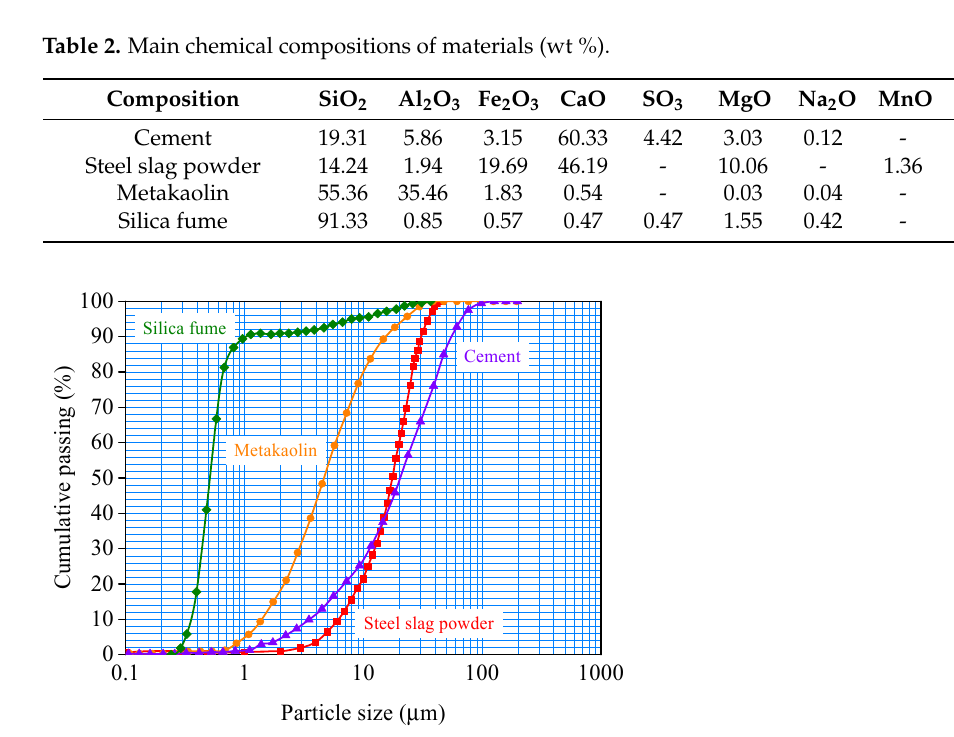
Figure 2. Samples of cementitious material components in this study ( a ) cement; ( b ) steel slag pow- der; ( c ) activator; ( d ) metakaolin and ( e ) silica fume. 2.2. Mix Proportions The experimental design method is often chosen according to the experimental pur- pose [33–35]. In order to study the influence of various factors on the mortar strength, the orthogonal method was adopted for designing the experimental mix proportions. Activa- tor, steel slag powder, metakaolin and silica fume were taken as four factors. The dosage of each factor was set at several levels according to the mass percentage of cementitious material. Due to the low activity of steel slag powder itself, the activation method is diffi- cult to have a good influence on the strength of steel slag cement mortar with excessive steel slag powder dosage, so the dosage of steel slag powder is set to 10%, 20%, 30%, and 40%, a total of four levels. Al 2 O 3 in metakaolin can accelerate the hydration reaction of SiO 2 in cementitious materials, so as to improve the strength of steel slag cement mortar. A small amount of metakaolin can have positive effect on the strength of steel slag cement mortar, so the dosage of metakaolin is set at four levels: 5%, 10%, 15%, and 20%. The silica